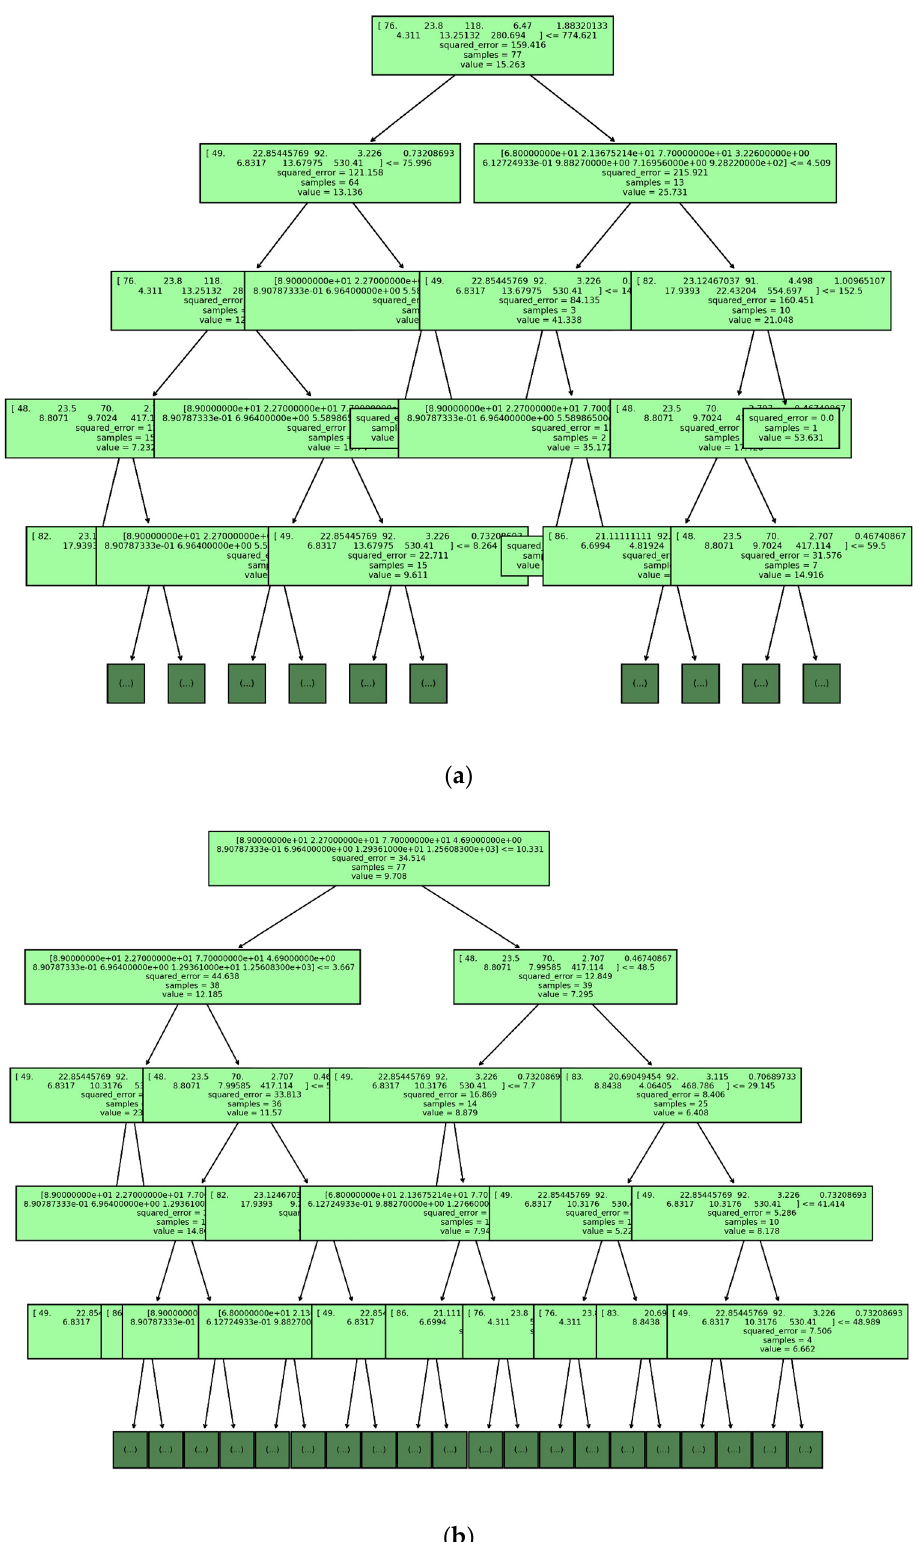
Figure 7. The decision-making process of a prediction model is graphically represented in ( a , b ), with a depiction of the various feature divisions and predictions at each stage. The illustration specifically focuses on the features Resistin and Adiponectin.